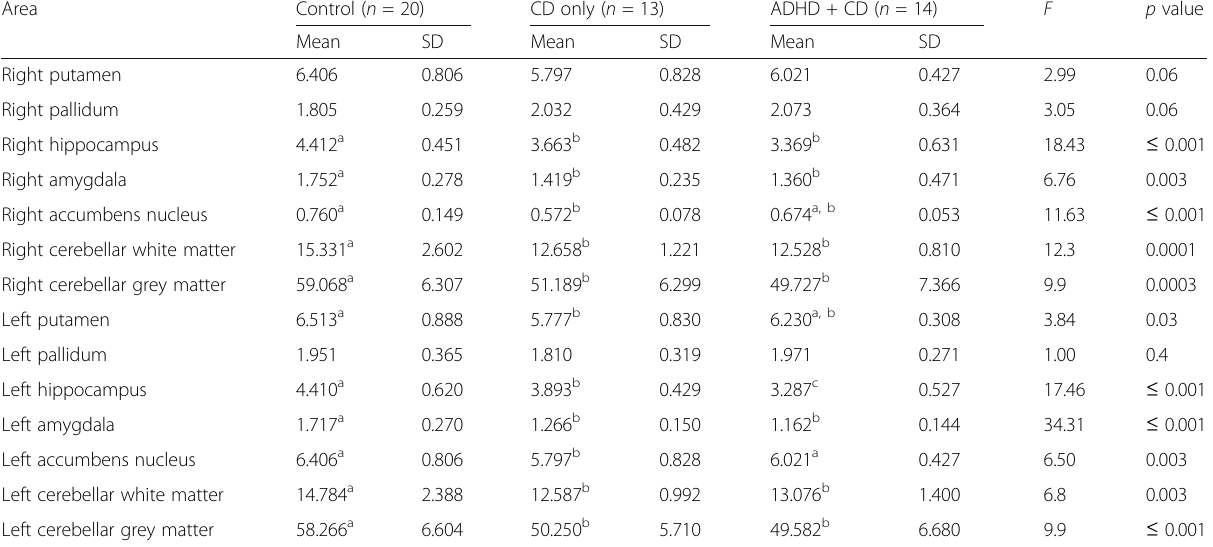
Table 4 Comparison between adolescents with conduct disorder, with and without ADHD, and control adolescents regarding subcortical volumes (cm 3